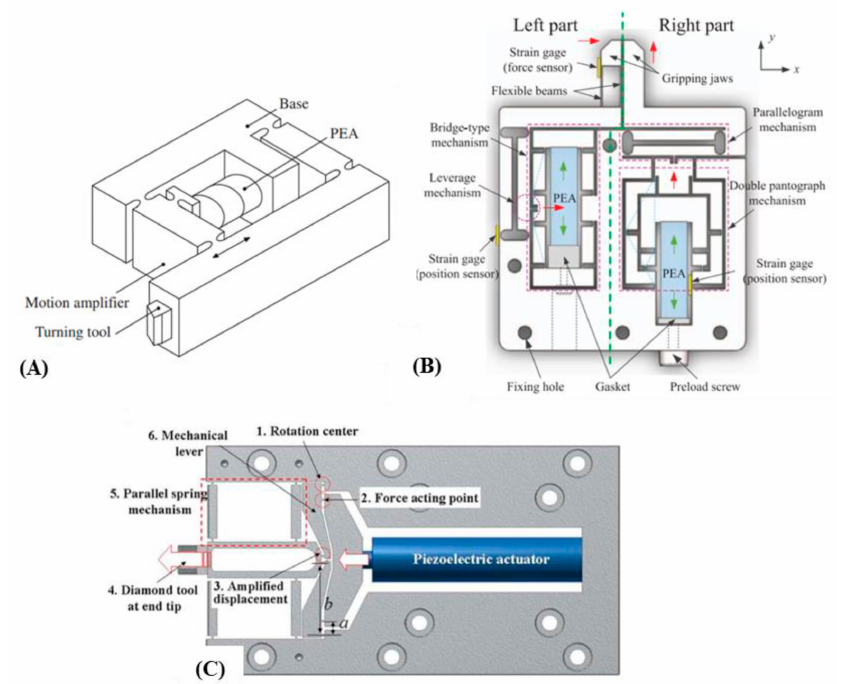
Figure 17. Long stroke FTSs. ( A ) Simple long stroke CM-based FTS [30]; ( B ) Serially combined CM [59]; ( C ) Symmetric type